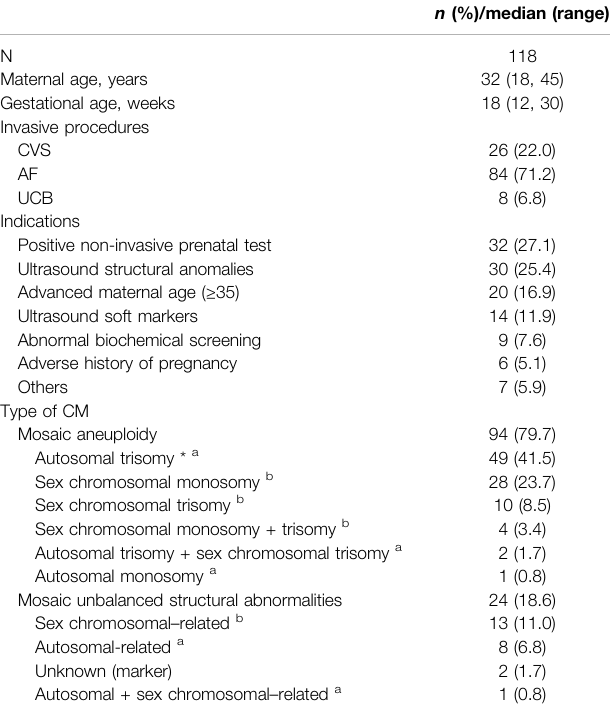
TABLE 1 | Clinical characteristics of 118 patients with CM in this